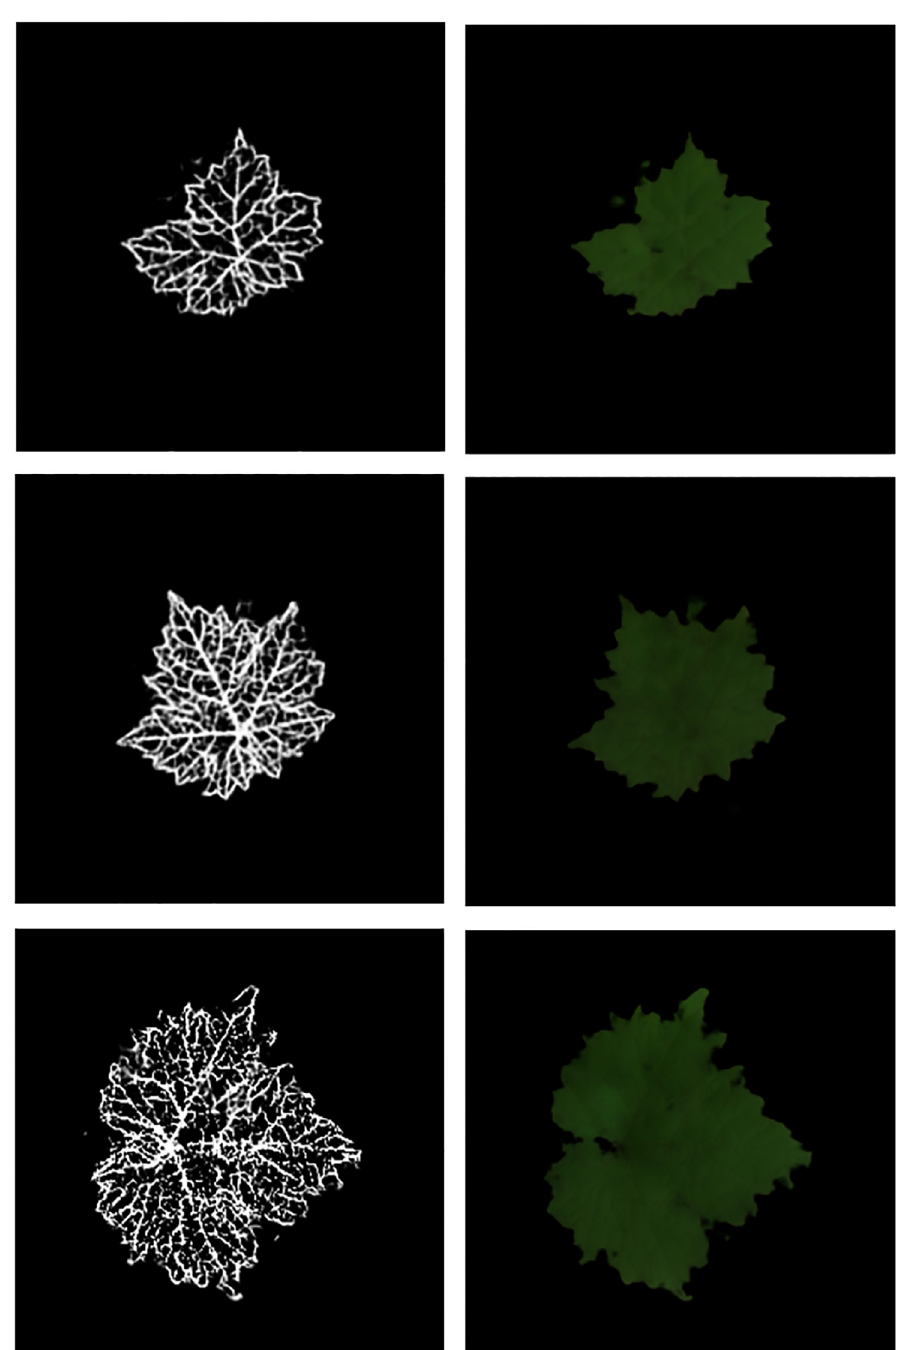
Fig 6. Full L2L translation results. Examples of synthetic colorized leaves along with the corresponding synthetic companion skeletons.